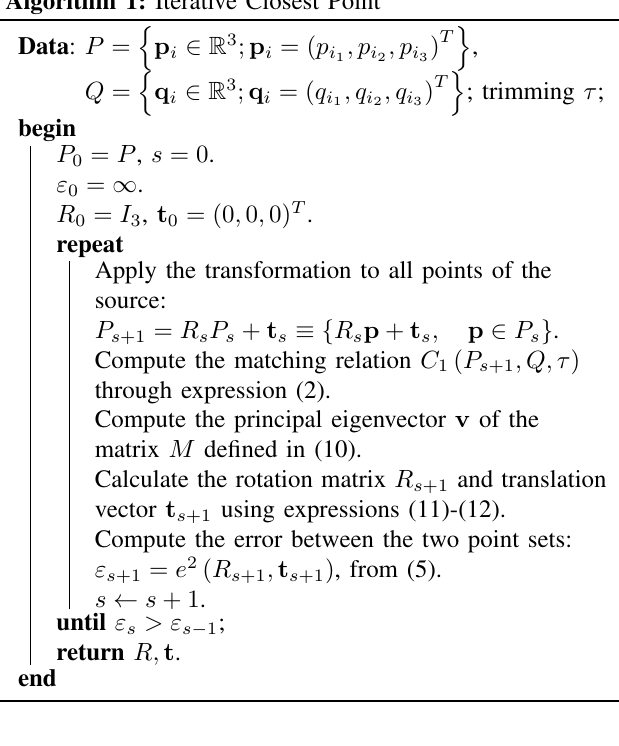
Algorithm 1: Iterative Closest